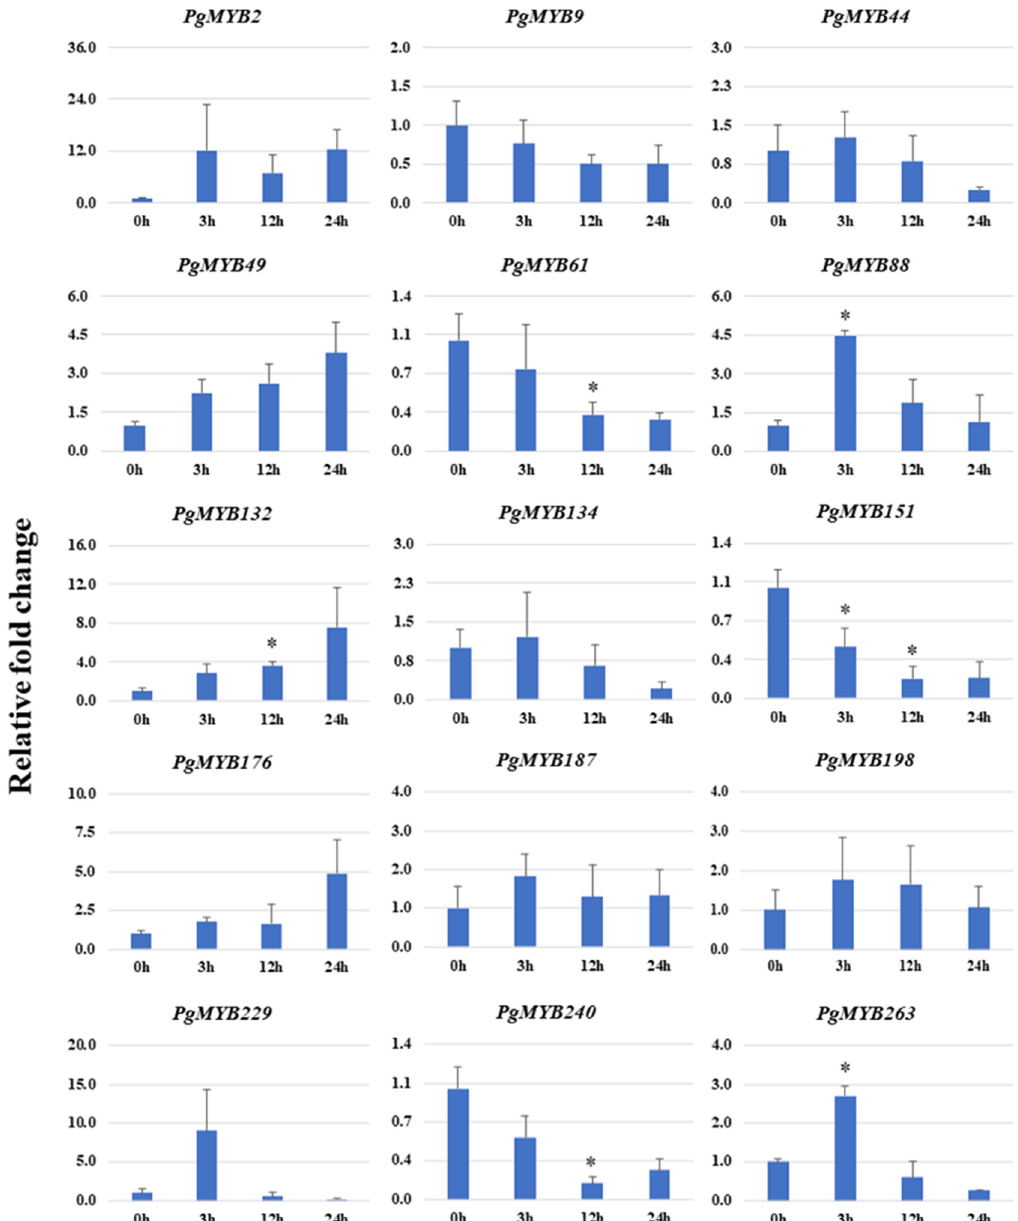
Figure 8. Relative expression analysis of PgMYB genes under heat stress at 0 h, 3 h, 12 h and 24 h time points. The X -axis represents different time points and the Y -axis indicates relative expression level. Significant difference in mean indicated by * p < 0.05, as obtained by Student’s t-test.